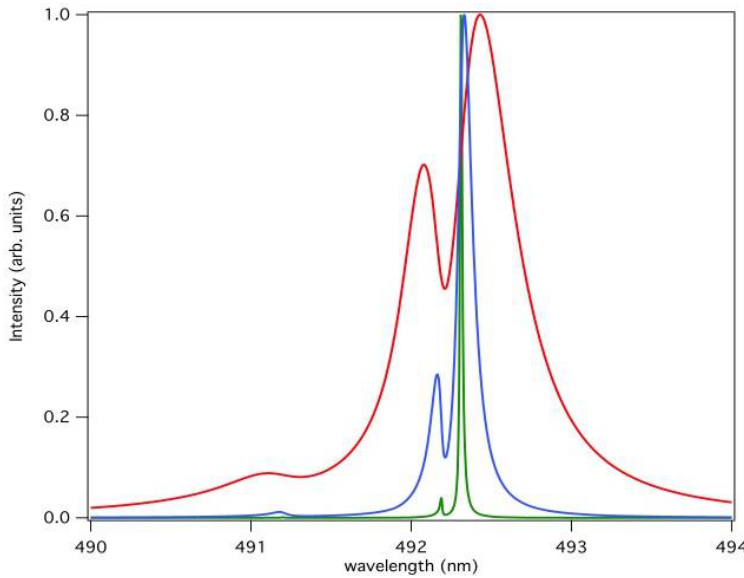
Figure 3. Synthetized profiles of spectral line He I 492.2 nm for T e = 1.16 × 10 4 K and T i = 300 K and for three densities, i.e., n e = 3 × 10 14 cm −3 (green line), n e = 2 × 10 15 cm −3 (blue line), n e = 1 × 10 16 cm −3 (red line).